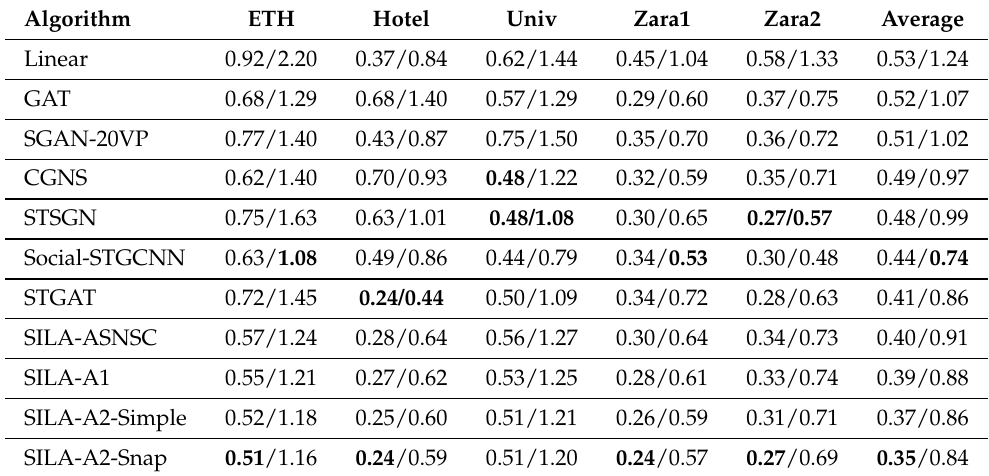
Table 5. ADE/FDE scores for each evaluation dataset under the leave-one-out strategy. Except the Linear model, all other models are probabilistic, where we consider the best out of 20 sampled